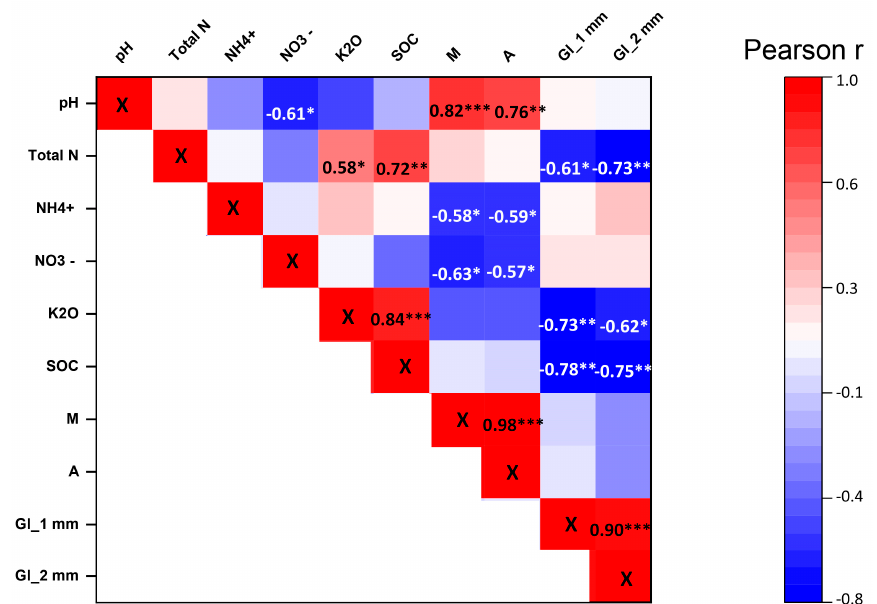
Figure 8. Pearson correlation analysis ( r ) between the investigated soil chemical and biological parameters for the di ff erent treatments over the course of the study. SOC refers to the soil organic carbon, M is the intensity of AMF root colonization, A is the arbusculum richness of the root system, Gl_1 mm and Gl_2 mm are the easily-extractable glomalin-related soil protein in < 1 mm and 1–2 mm soil fractions, of the investigated soil samples, respectively. Correlation is significant * at the 0.05, ** at the 0.01, and *** at the 0.001